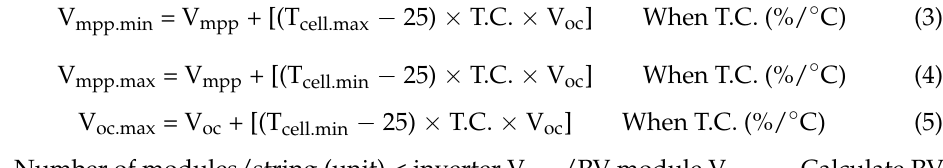
8 of 17 Figure 5. Energy harvesting from PV, wind in WD valley . Energy harvesting from PV, wind in WD valley as, sunlight radiation is the major energy source, supplying around 77% of the total energy needed using photovoltaic pan- els (72-cell panels); calculations are estimated as elsewhere [63,64]. Secondly, wind energy is a vital energy source as WD is a coastal city, and the wind velocity is around 10.5 m/s